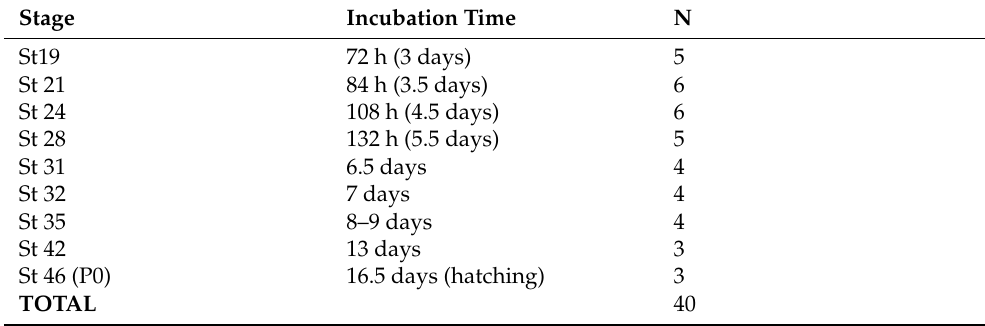
Table 1. Stages of development and number of C. coturnix embryos used in the present study.